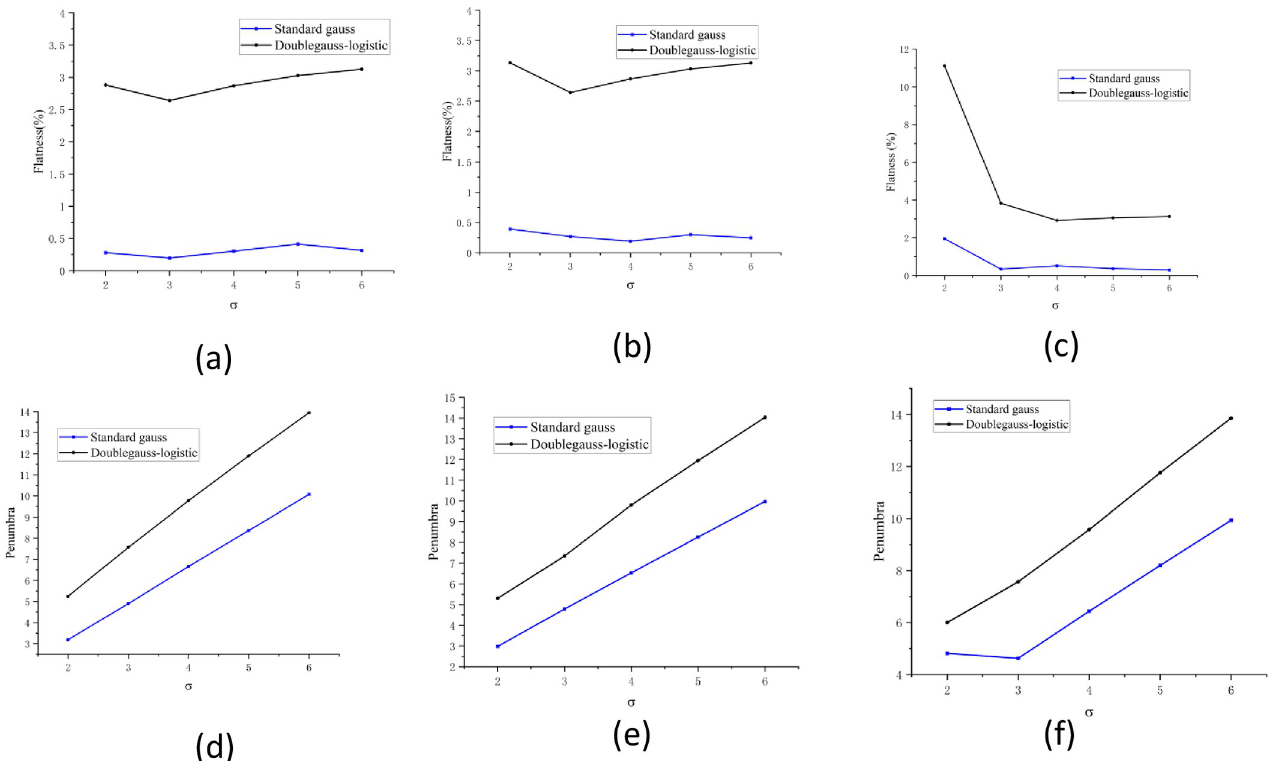
Fig 6. The influence of different spot sizes on flatness and penumbra. (a-c) The influence of different beam spot (2–6 mm) on dose uniformity and (d-f) penumbra for PB scanning (PBS) CIRT.